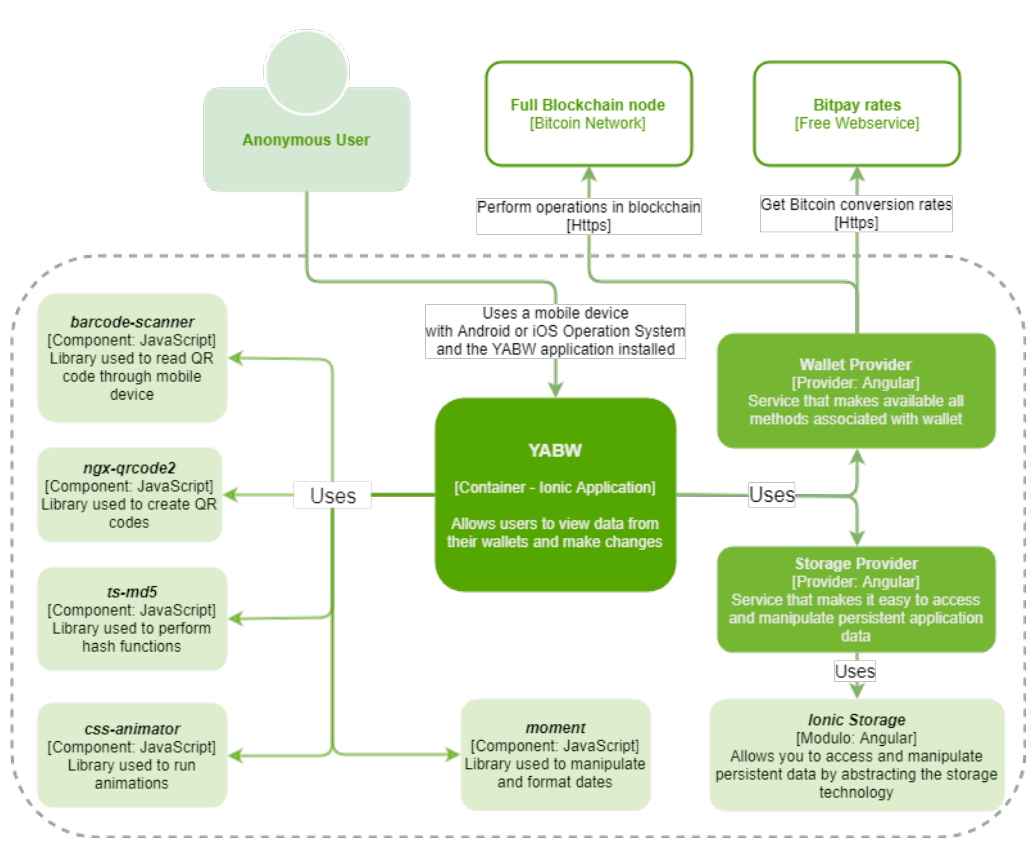
Figure 1. System context diagram [C4–Level 1].